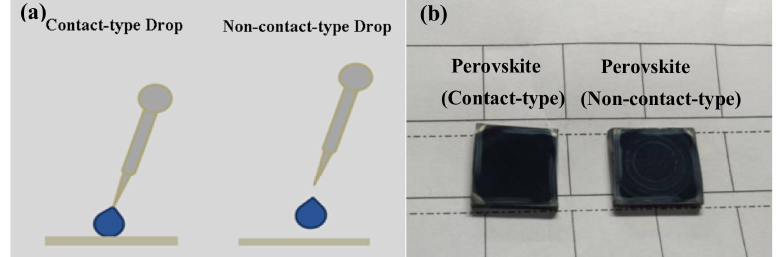
Figure 1. Schematic illustrations for drop method and picture of perovskite films: ( a ) Schematic illustrations for contact-type method and non-contact-type method to drop MAI solution; ( b ) Picture of perovskite films dropped by contact-type method and non-contact-type method.